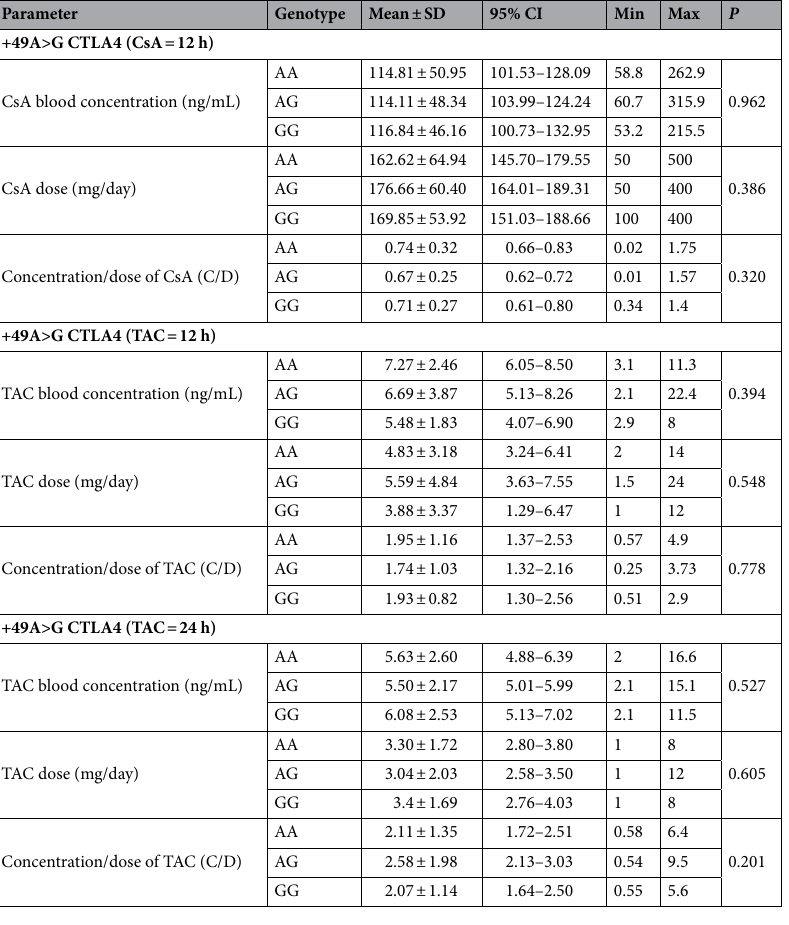
Table 3. Comparison of tacrolimus (TAC) and cyclosporine A (CsA) concentration in blood and its dosing between genotypes of CTLA4 +49A>G polymorphism (rs231775) in patients receiving the drug every 12